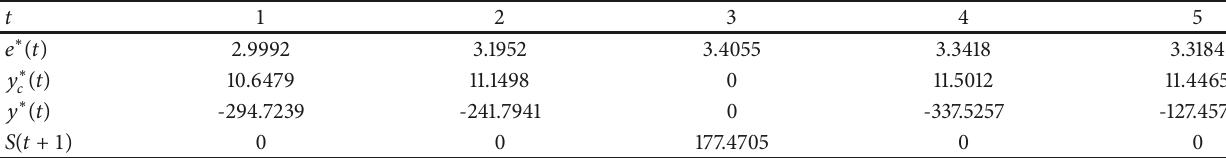
Table 2: Optimal decisions of multi-cycle emission reduction.